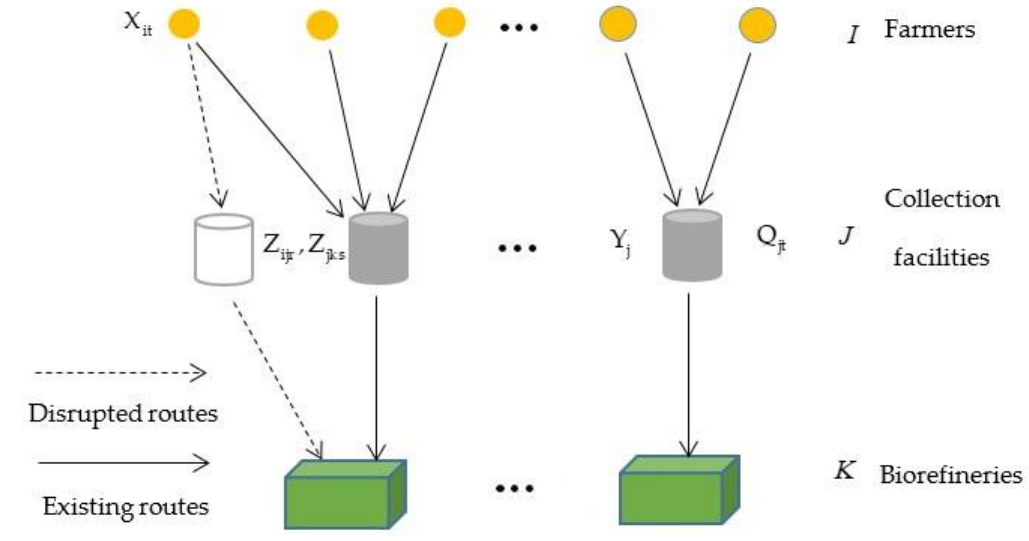
Figure 1. Biomass supply chain structure.